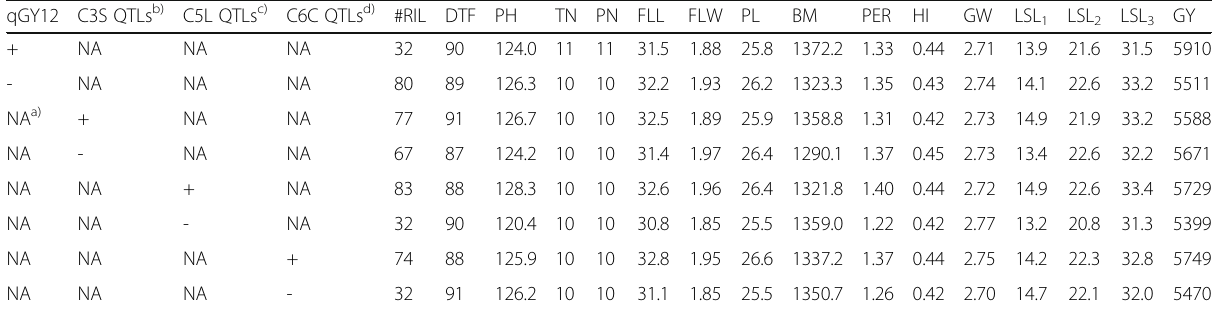
Table 8 Phenotypic effect of grain yield QTL and QTL clusters identified in irrigated control